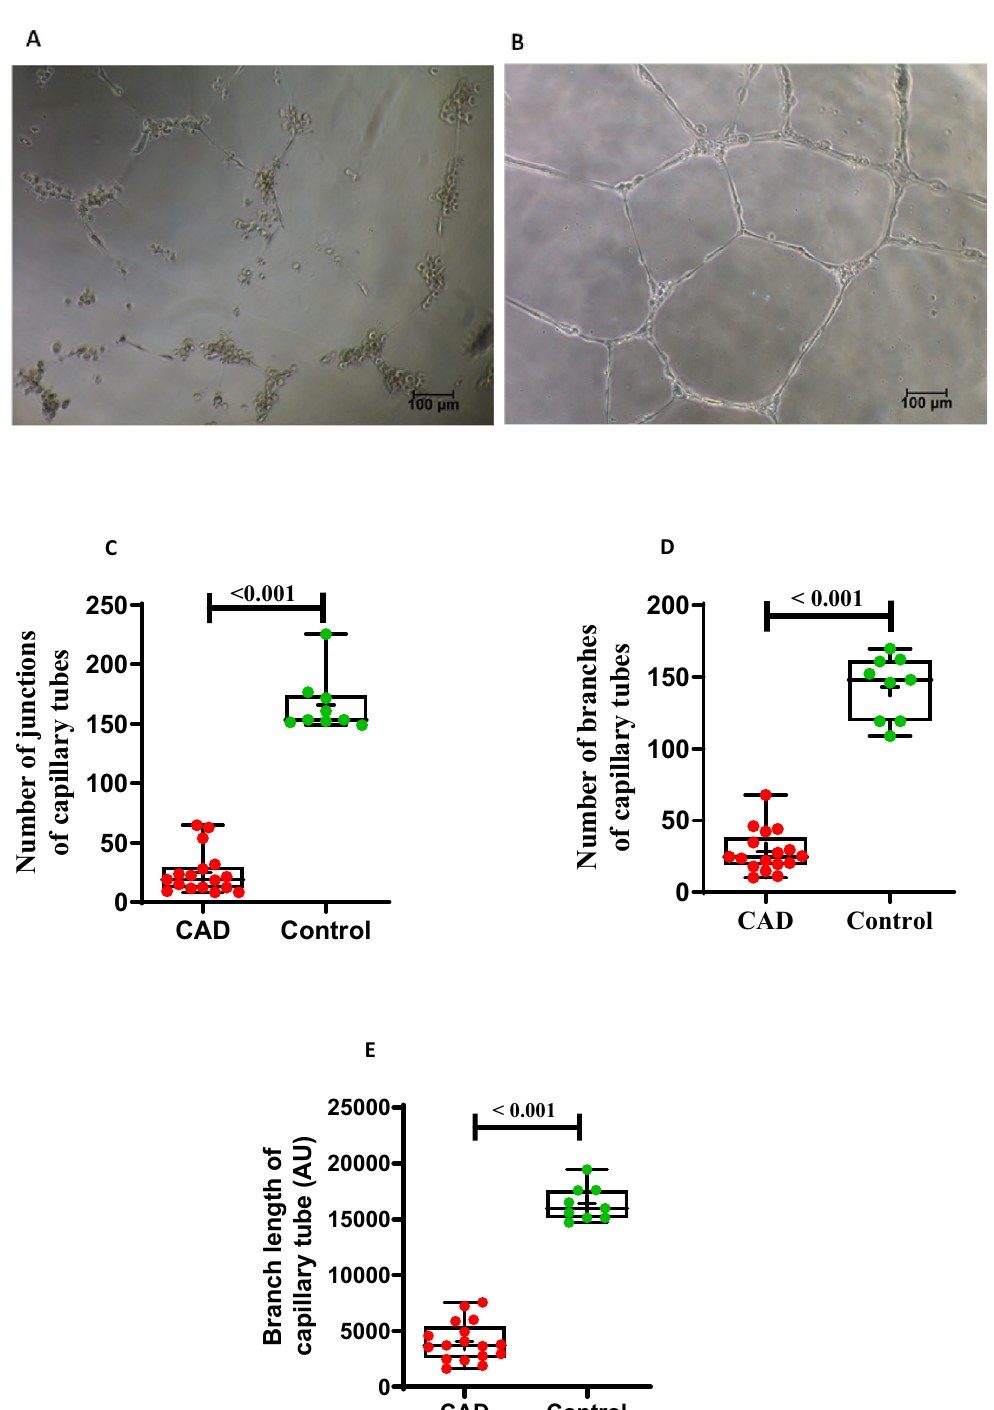
Figure 8. In vitro angiogenesis or capillary tube formation by ECFCs in CAD and healthy control group . (A ) and ( B ) shows images of capillary tube formation by ECFCs on Matrigel matrix in a representative CAD and control sample respectively. Images are at 10 × magnification with 100 µm scale bar. ( C ) represents number of branches of capillary tubes in CAD (n = 17) and control group (n = 9). ( D ) depicts number of junctions of capillary tube in CAD (n = 17) and control (n = 9). ( E ) shows branch length of capillary tubes formed in cased (n = 17) and controls (n = 9). Box-and-whisker plot representing median (IQR), max/min and dots are average values; obtained from experimental duplicates. Significance was assessed between the group by Mann–Whitney U test. p ≤ 0.05 was considered statistically significant. AU: Arbitrary Unit